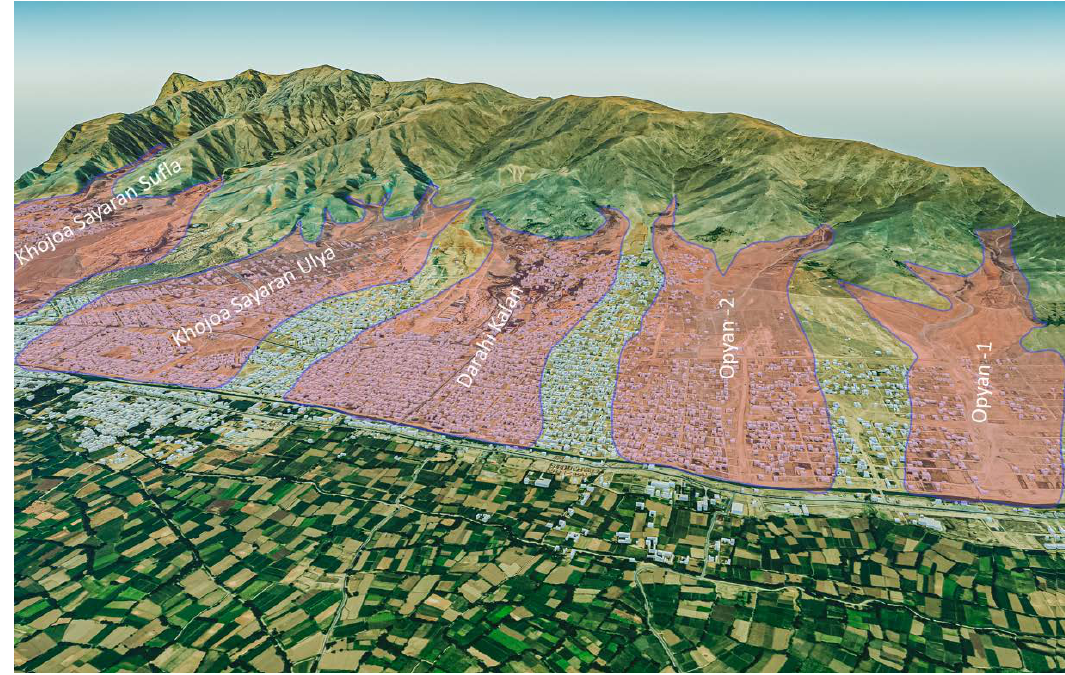
Figure 2. Compounds in Charikar city are at risk of flooding due to a lack of regular urban planning. The flood path information is collected from the Surface Water Resources Department of Afghanistan.